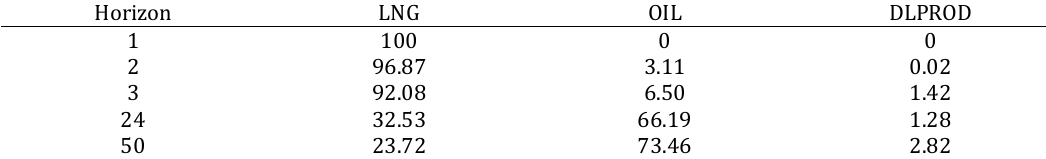
Table 2: Percent contribution of shocks to the overall variability of the LNG prices Horizon LNG OIL DLPROD 1 100 0 0 2 96.87 3.11 0.02 3 92.08 6.50 1.42 66.19 1.28